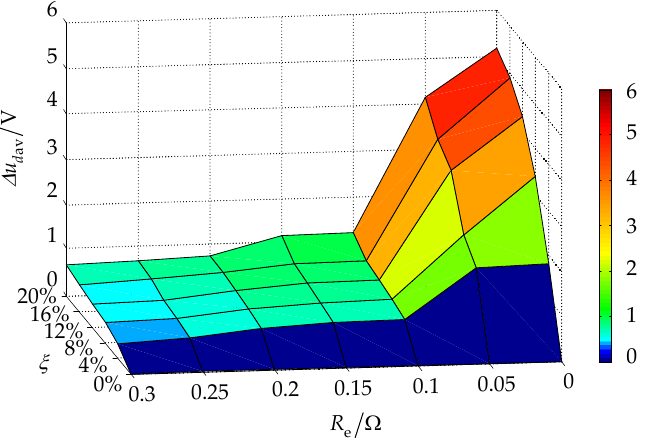
Figure 15. The variation diagram of ∆ u d av with the external contact resistance and the percentage for the number of short-circuited turns.